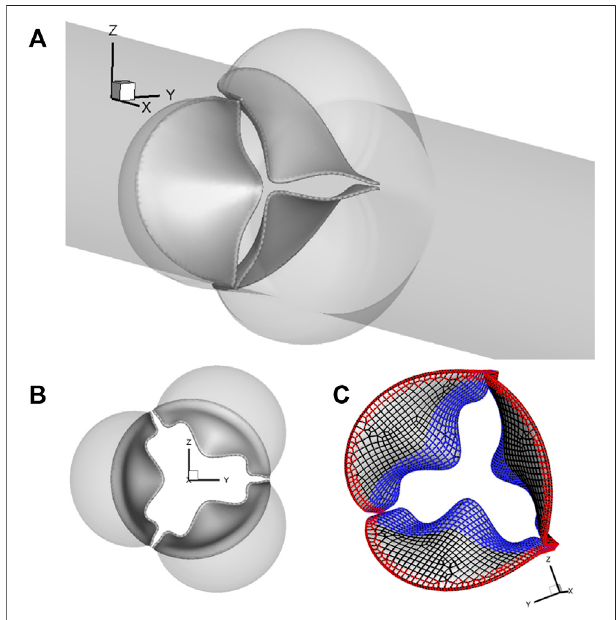
FIGURE 1 | (A) Computational model of the aorta root, where the aortic valveisplacedwithinthesinusregionofthesimpli fi edstraightaorta. (B) Aortic valve and three sinuses. (C) Fixed nodes (red markers) and the prescribed contact detection region (blue